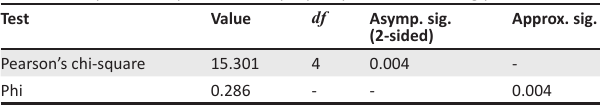
TABLE 5: Delphi technique versus step-by-step decision-making process.